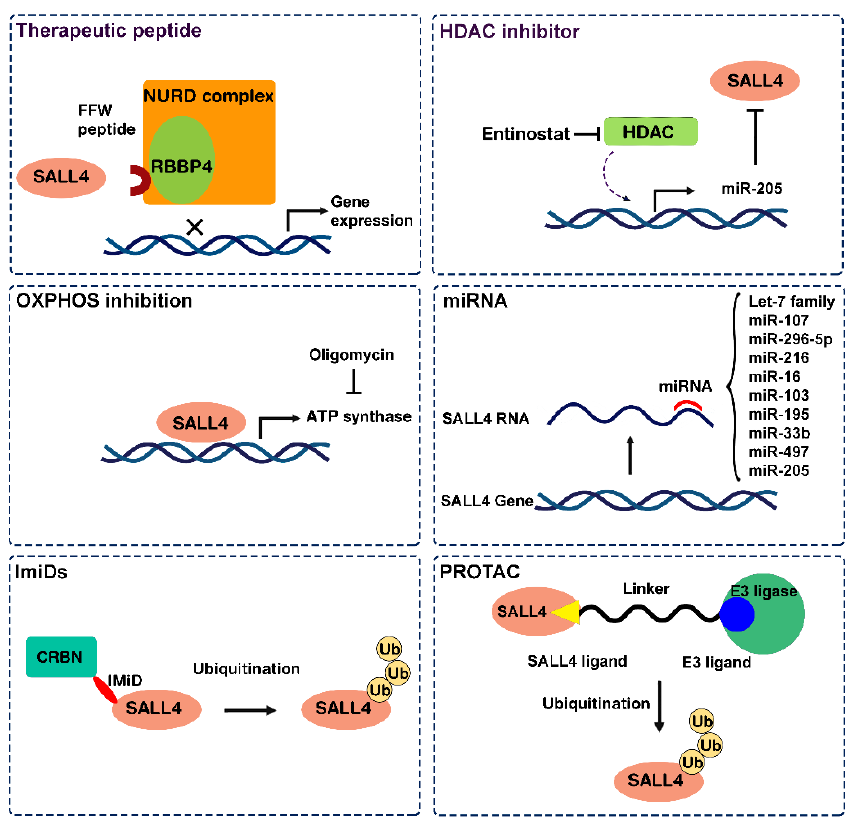
Figure 2. Scheme of the different drugs suggested to target SALL4 in cancer. OXPHOS: Oxidative phosphorylation, IMiDs: Immunomodulatory imide drugs, PROTAC: Proteolysis-targeting chimae- ras.